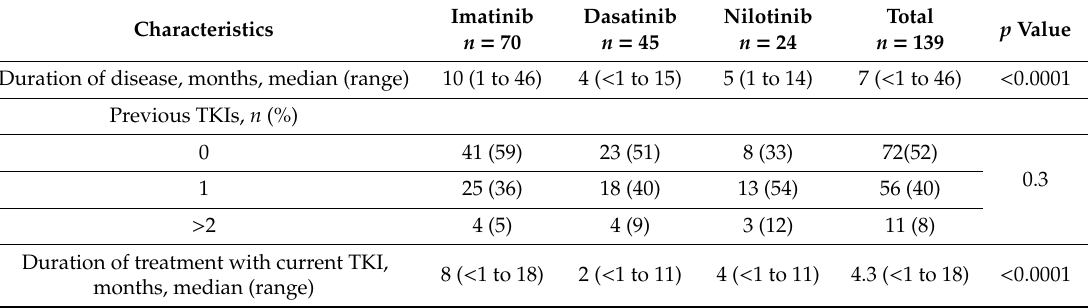
Table 2. Disease characteristics of study